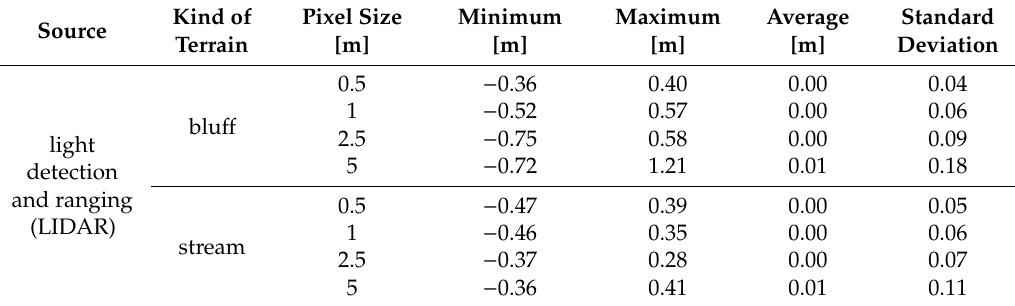
Table 2. Statistics of the differences between two types of interpolation.